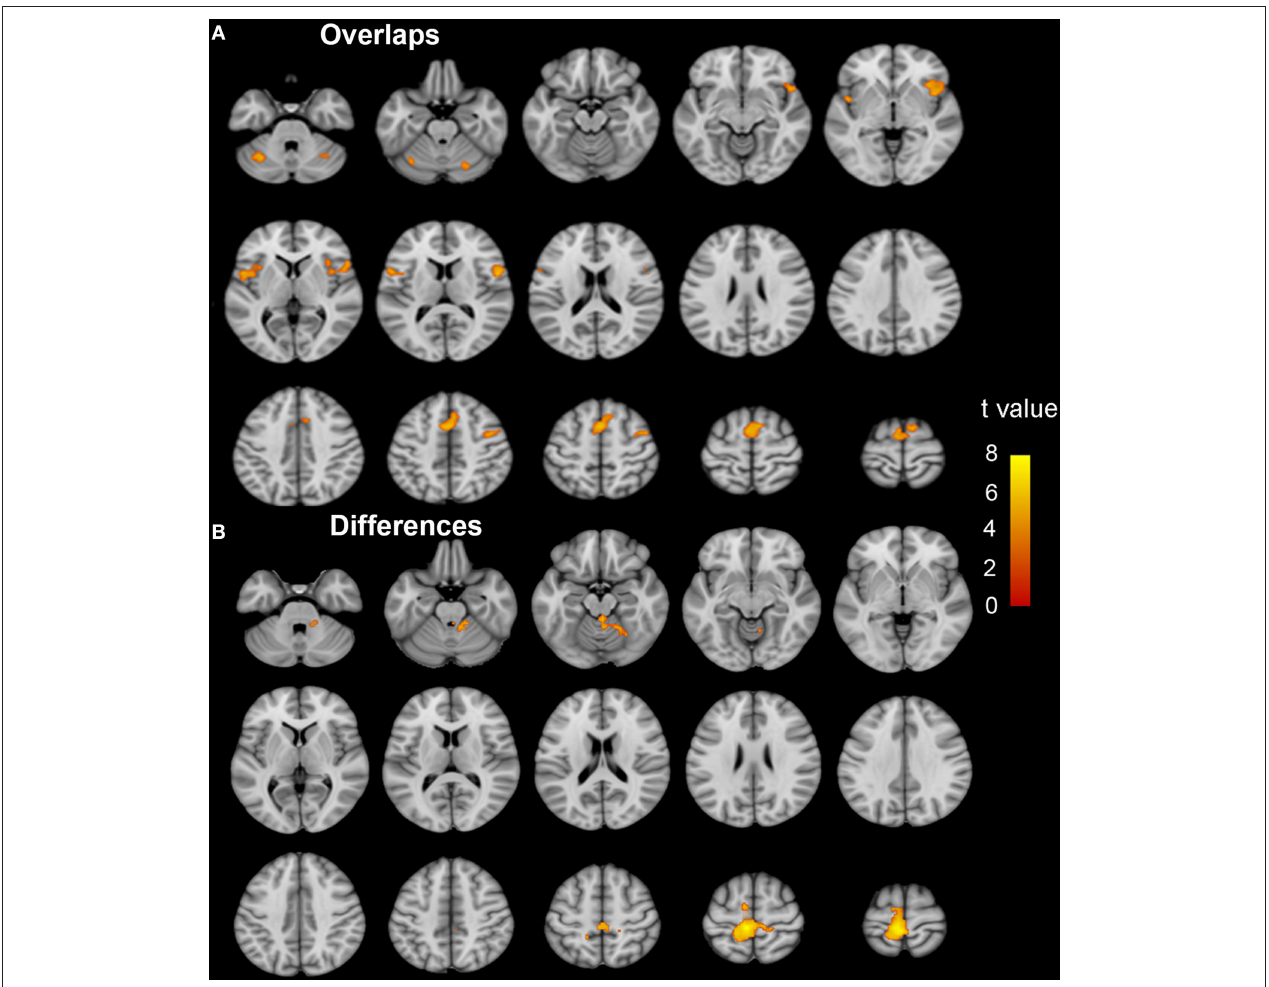
FIGURE 4 | The coactivation and differences between the MI and ME tasks in ISCI patients. The coactivation pattern of the MI and ME tasks was similar but weaker than that of the NC group (A) . Compared to the ME task, the MI task evoked weaker activation in the bilateral SMA, CB lube 6, IFO, aINS, left CB Crus 1, MFG, left paracentral lobule, precuneus, right CB vermal 4–5 and lobules 4–6 (B) . Significant activation was considered at a voxel-wise threshold of q < 0.01 (FDR correction) and cluster ≥ 30 voxels. The right side of the image corresponds to the right hemisphere. The color bar represents the t -values. MI, motor imagery; ME, motor execution; ISCI, incomplete spinal cord injury; NC, normal controls; SMA, supplementary motor area; CB, cerebellum; IFO, inferior frontal operculum; aINS, anterior insula; MFG, middle frontal